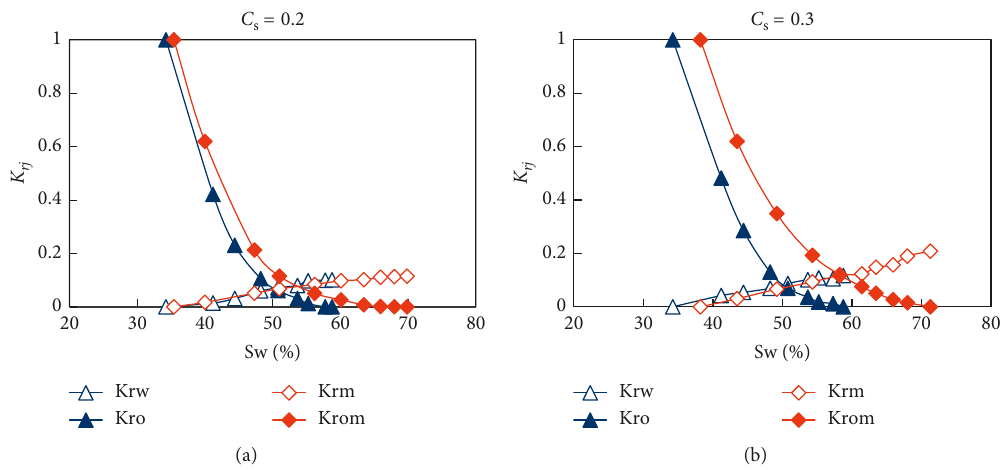
Figure 4: Relative permeability curves under different surfactant